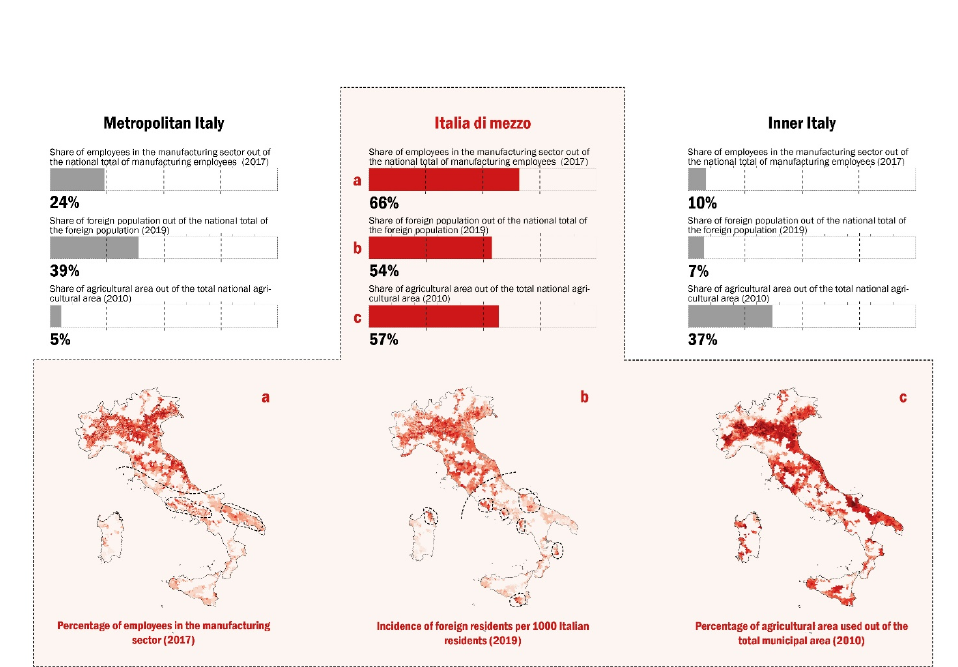
Figure 3: Common features of Italia di